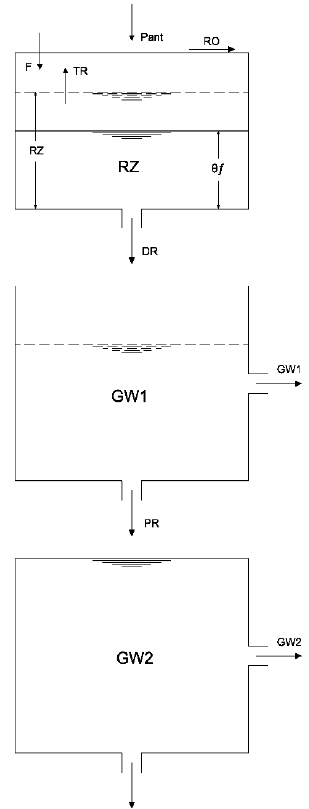
Figure 1. Schematic diagram of the water balance sub-module in SCHydro model.